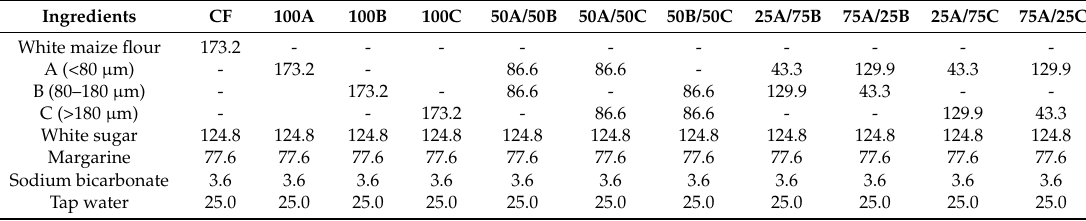
Table 1. Gluten-free cookie formulations presented in grams with different percentages of maize flour and fractions A (<80 µ m), B (80–180 µ m) and C (>180 µ